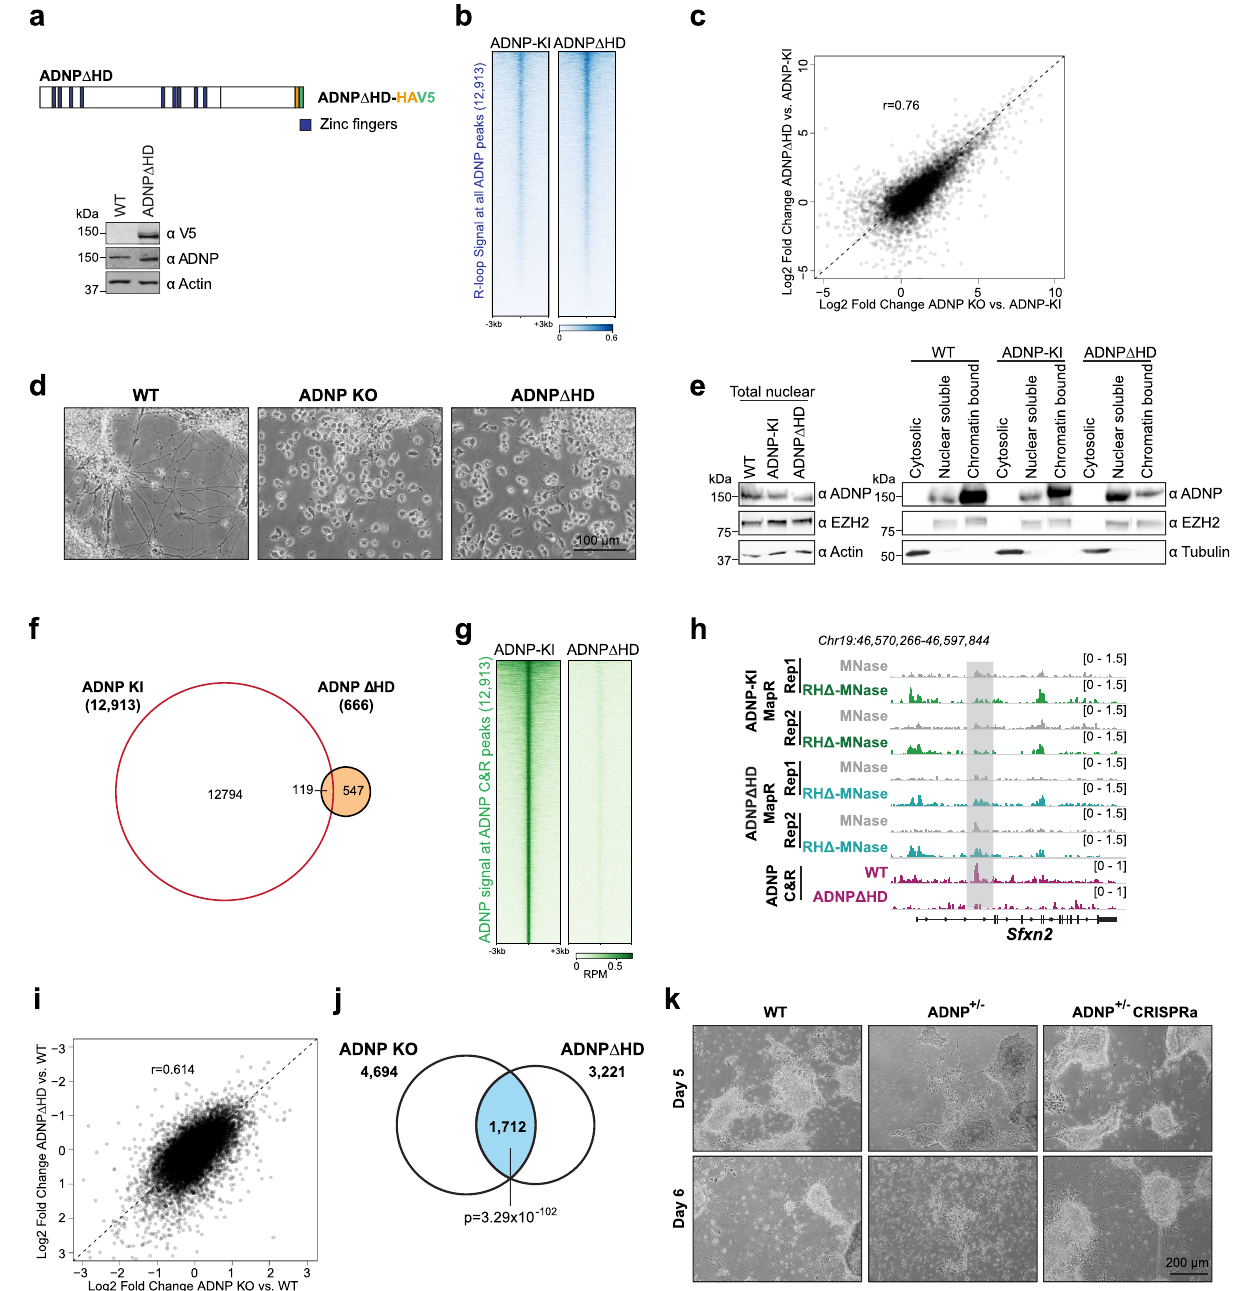
Fig. 6 ADNP homeodomain deletion results in protein mislocalization and R-loop accumulation. a Schematic of HA and V5 epitope-tagged ADNP Δ HD (top). Zinc fi ngers are in blue. Western blot for V5 tag and ADNP in parental WT and ADNP Δ HD mESCs (bottom). Actin serves as loading control. Antibodies indicated on the right. b Heatmap of normalized MapR signal in ADNP-KI and ADNP Δ HD mESCs across 6-kb windows centered on ADNP CUT&RUN peaks. Rows are sorted in decreasing order by mean signal across all samples. c Scatterplot of log2 fold changes in R-loop read density between control and ADNP KO mESCs and log2 fold changes between ADNP-KI and ADNP Δ HD mESCs across 12,913 ADNP peaks. Pearson correlation, 0.76. d Representative images of WT, ADNP KO, and ADNP Δ HD cells on day 5 of differentiation. e Western blot for ADNP, EZH2, Actin, and Tubulin in WT, ADNP-KI, and ADNP Δ HD mESCs total nuclear extract (left), and upon fractionation into cytosolic, nuclear soluble and chromatin-bound fractions (right). Antibodies are indicated on the right. f Venn diagram showing overlap between 12,913 ADNP CUT&RUN peaks and 666 ADNP CUT&RUN peaks called in ADNP-KI and ADNP Δ HD, respectively. g Heatmap of ADNP CUT&RUN signal (RPM) in ADNP-KI and ADNP Δ HD mESCs across 6-kb windows centered on 12,913 ADNP peaks. Rows are sorted in decreasing order by mean signal across all samples. h Genome browser view of the Sfxn2 gene showing MapR signal (RPM) in ADNP-KI and ADNP Δ HD mESCs and ADNP CUT&RUN signal (RPM) in ADNP-KI and ADNP Δ HD mESCs. i Scatterplot of log2 fold changes in RNA-Seq expression between WT and ADNP KO mESCs and log2 fold changes between WT and ADNP Δ HD mESCs for 11,973 expressed genes. Pearson correlation, 0.614. j Venn diagram showing overlap between 4694 genes differentially expressed in ADNP KO and 3221 genes differentially expressed in ADNP Δ HD. p -value of overlap = 3.29 × 10 − 102 , hypergeometric test. k Representative images of WT, ADNP + / − , and ADNP + / − CRISPRa cells on days 5 and 6 of neuronal differentiation. Source data underlying a , d , e , k are provided as a Source data fi